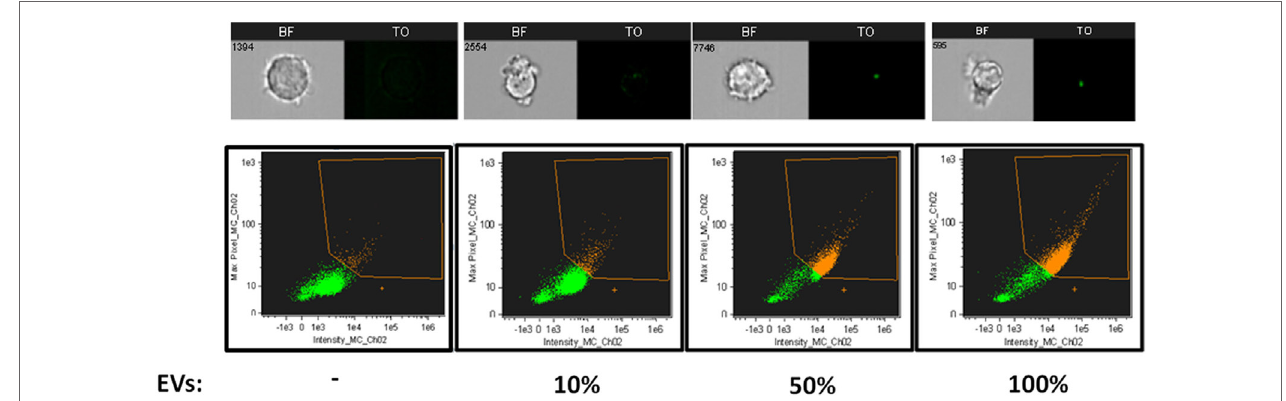
FIgURe 3 | Relative Plasmodium falciparum ( Pf ) - derived extracellular vesicles (EV) uptake into monocytes. Relative amounts of EVs (100, 50, 10, and 0%) were stained using the same amount of [thiazole orange (TO)] dye. THP-1 cells were incubated with RNA (TO)-labeled EVs for 5 min before being fixated and imaged by imaging flow cytometry. Graphs show the percentage of TO-labeled EV-positive cells, gated according to unlabeled EVs. Representative results from experiments out of three are shown. Abbreviation: BF, bright